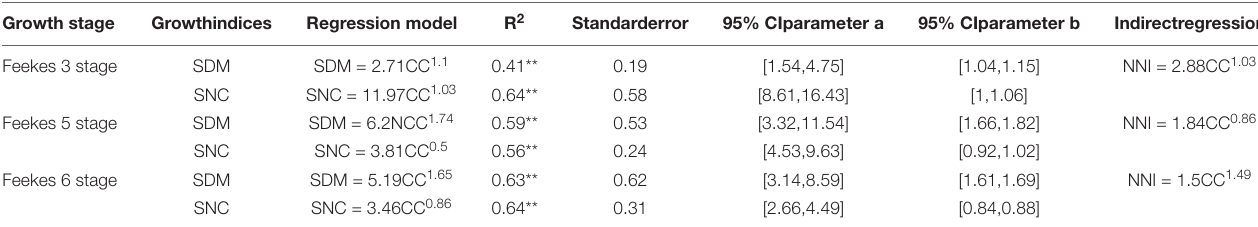
FIGURE 6 | The relationship between canopy cover and shoot nitrogen concentration across different growth stages of winter wheat (A) Feekes 3; (B) Feekes 5; (C) Feekes 6. TABLE 7 | The relationships between nitrogen nutrition index and canopy cover across different growth stages using the indirect